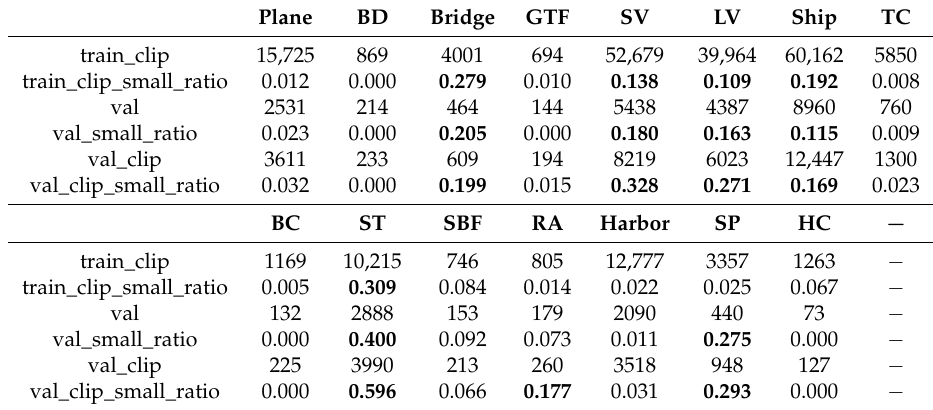
Table 2. Sample distribution statistics. We highlight in bold the value of the small ratio when it is bigger than 0.1, which means there are many small objects in the corresponding